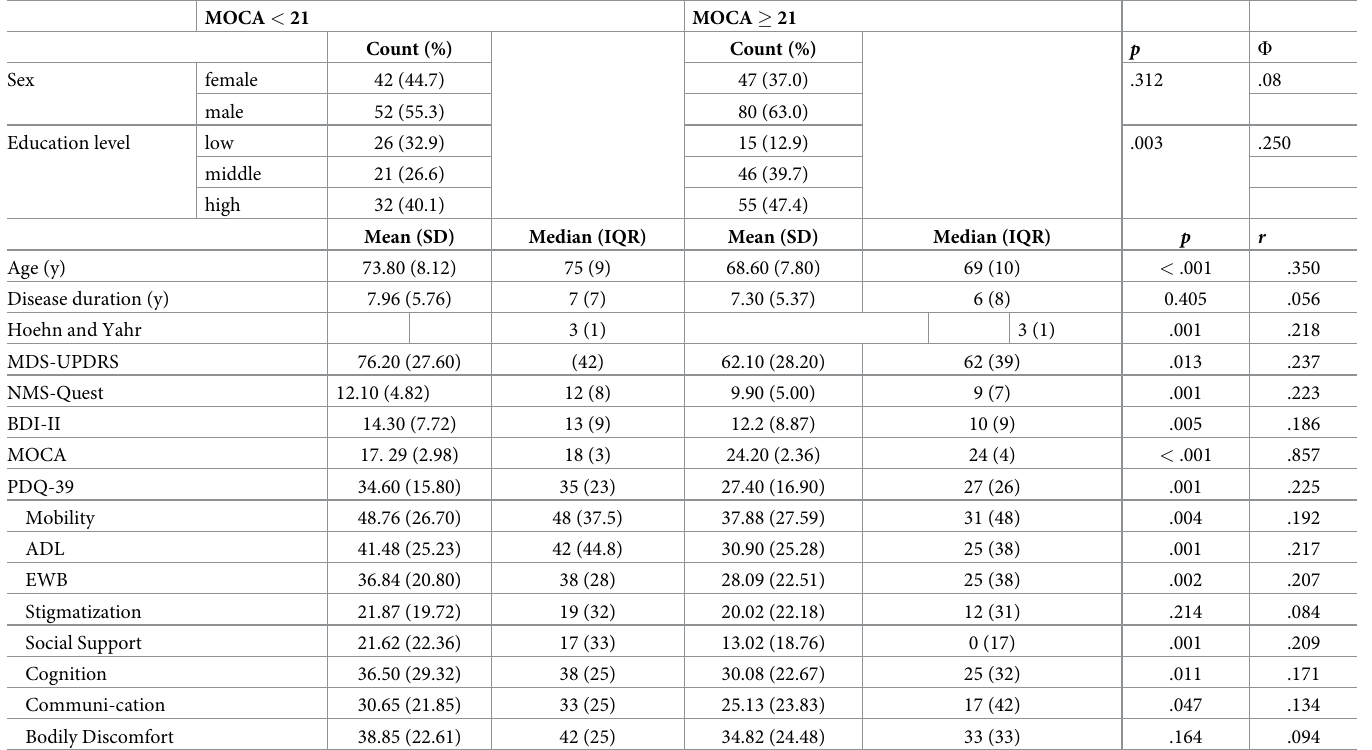
Table 1. Clinical and demographic data of people with low and high MOCA scores.